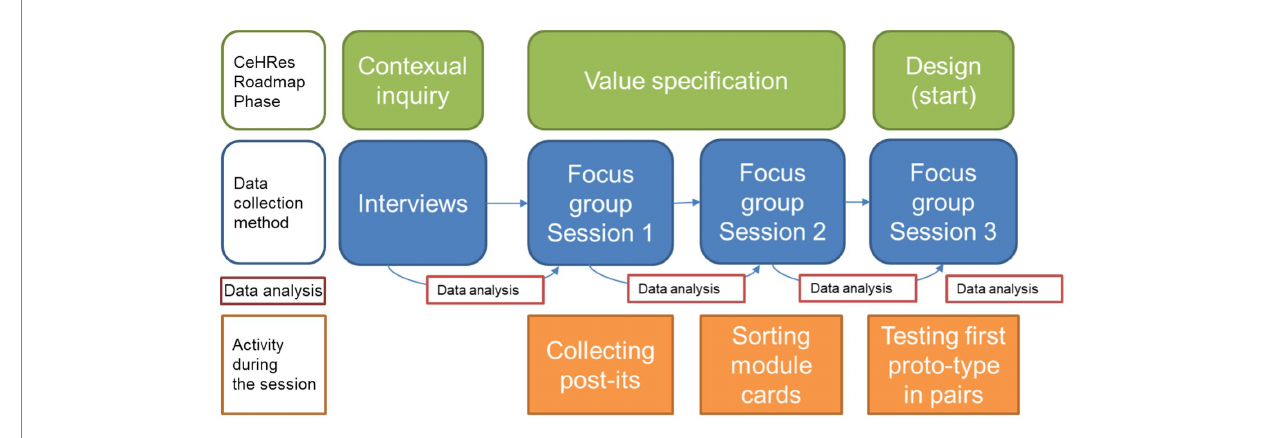
FIGURE 1 Overview of the study design and used